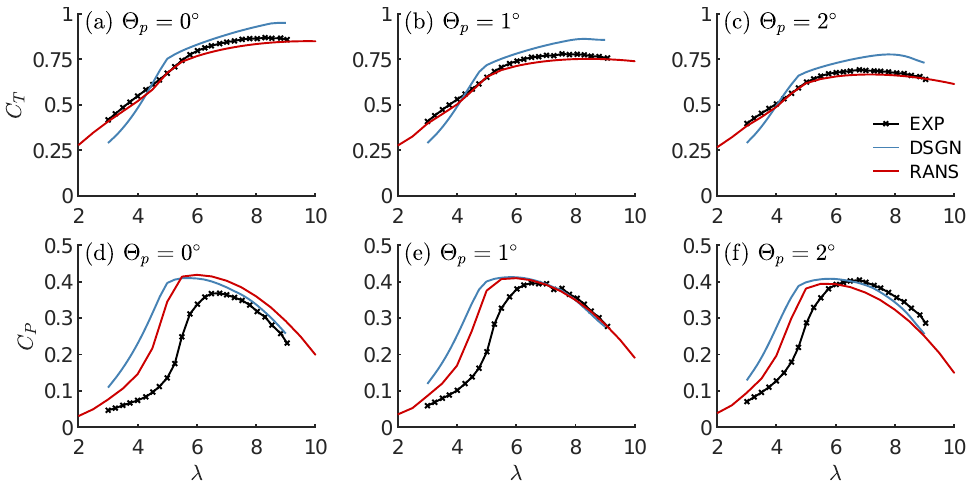
Figure 4. Comparison of ( a – c ) thrust C T and ( d – f ) power coefficient C P as a function of tip speed ratio λ obtained from measurement (EXP), 2D airfoil calculations (DSGN) and numerical simulation (RANS) for pitch angles Θ p = 0 ◦ ,1 ◦ ,2 ◦